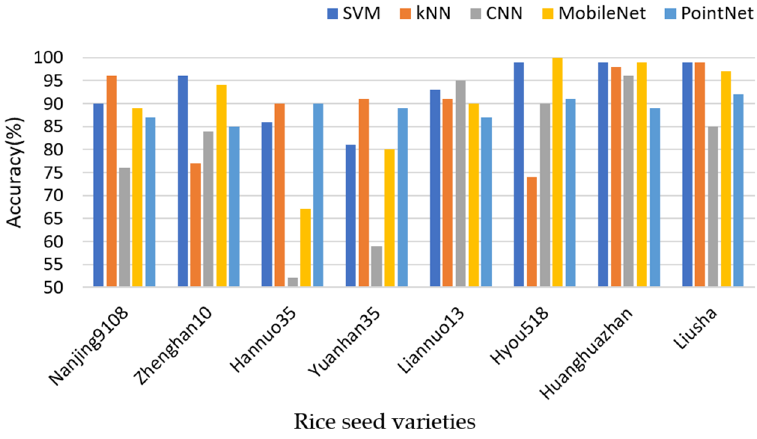
Figure 11. Accuracy of the different models for each species of rice seeds.